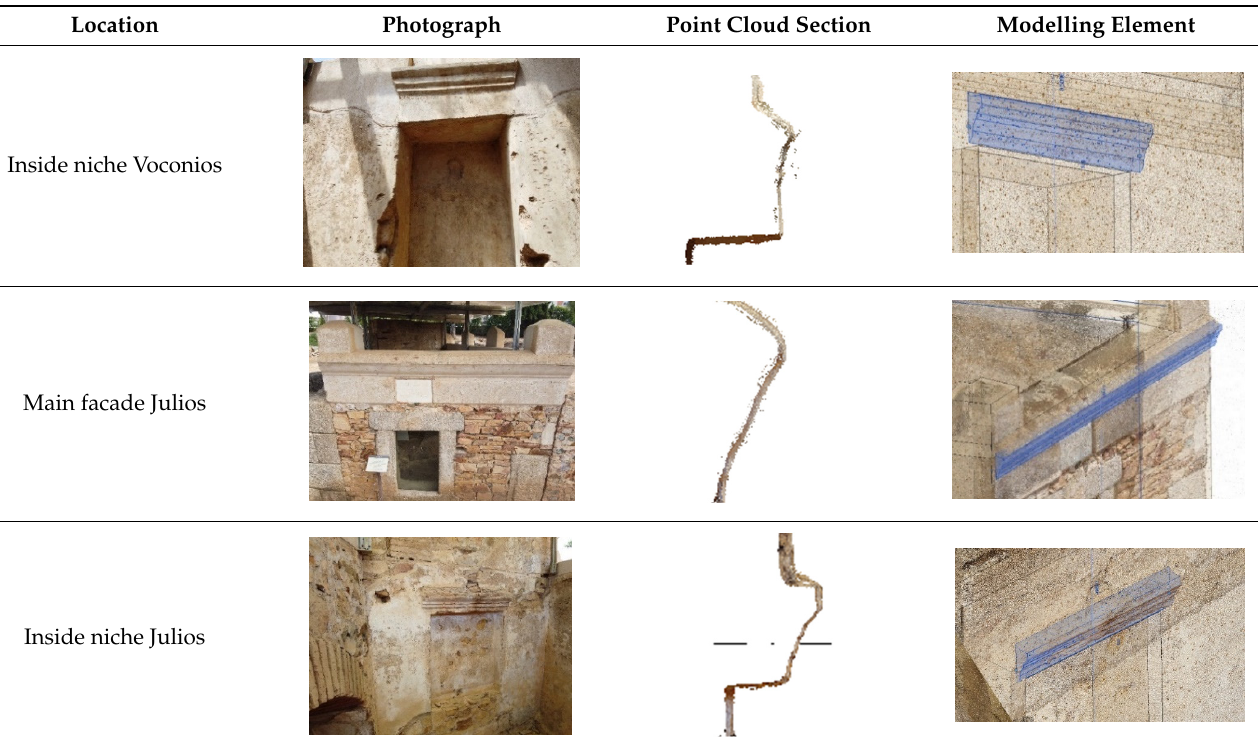
Table 7. Modelling of the decorative elements: Cornices.